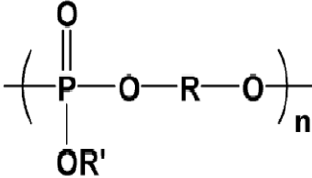
Figure 5. General structure of polyphosphoesters where R = divalent organic